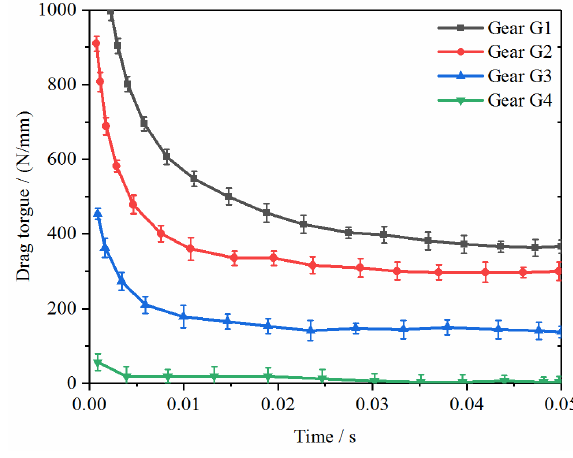
Figure 5. The resistance moment changes of the four gears.